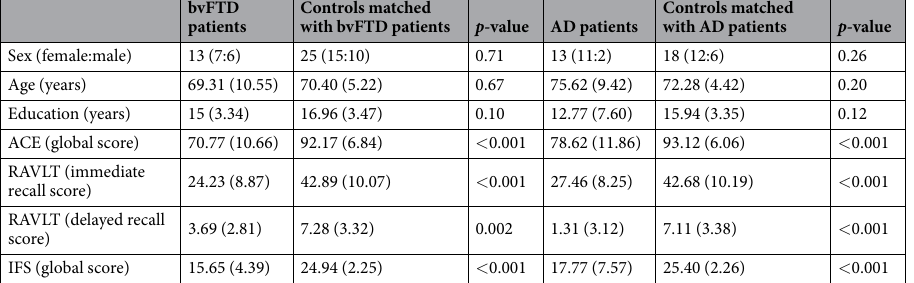
Table 1. Demographic and neuropsychological results. Means and (standard deviation). bvFTD = behavioral variant of frontotemporal dementia, AD = Alzheimer disease. We used t-test for variables comparisons between groups and, particularly, the pearson chi squared test for sex